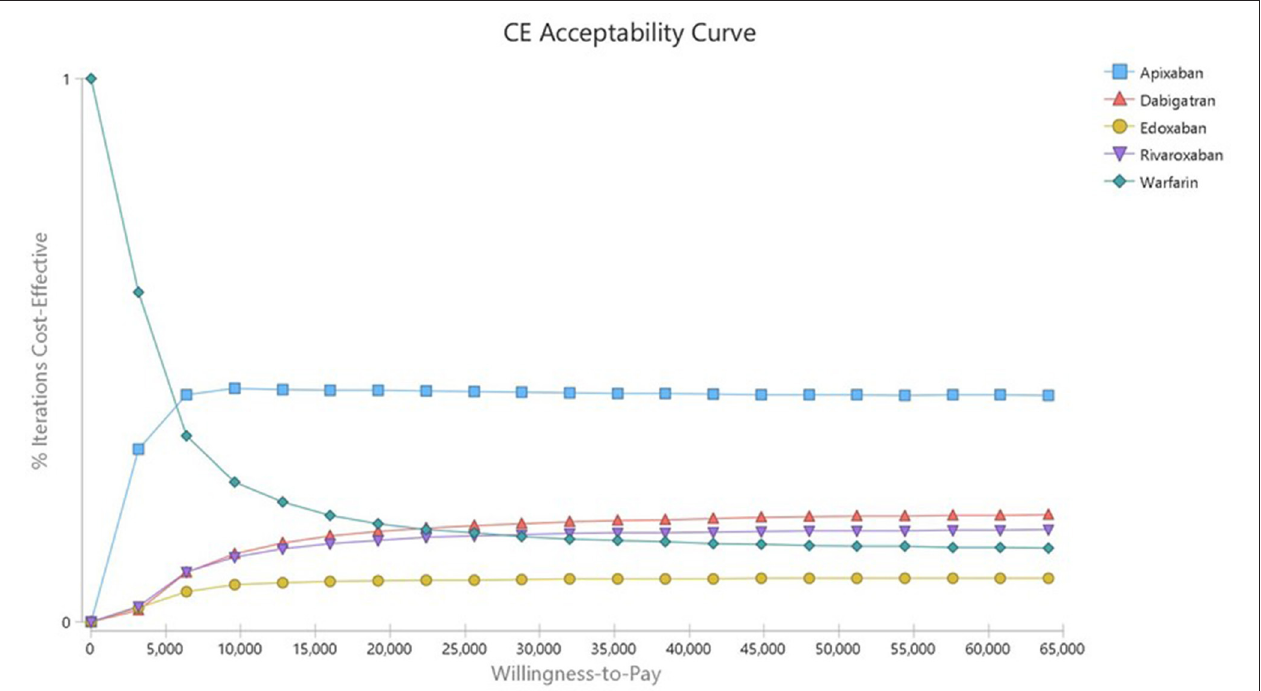
FIGURE 1 | Cost-effectiveness acceptability curve of Warfarin vs. DOACs in AF patients with intermediate stroke